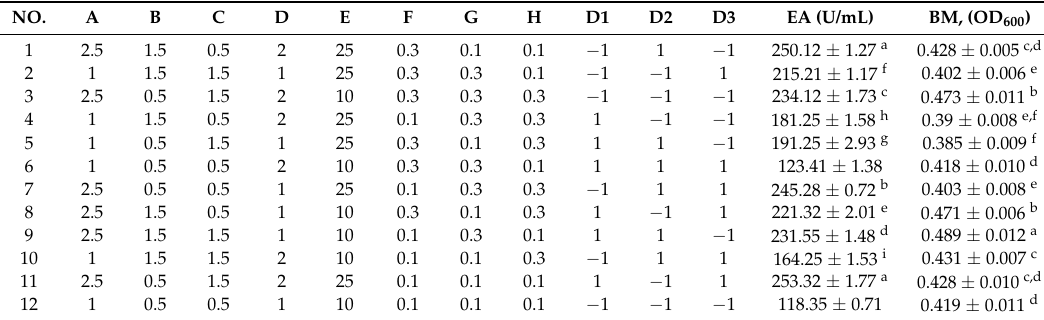
Table 2. Arrangement and experimental results of the PB